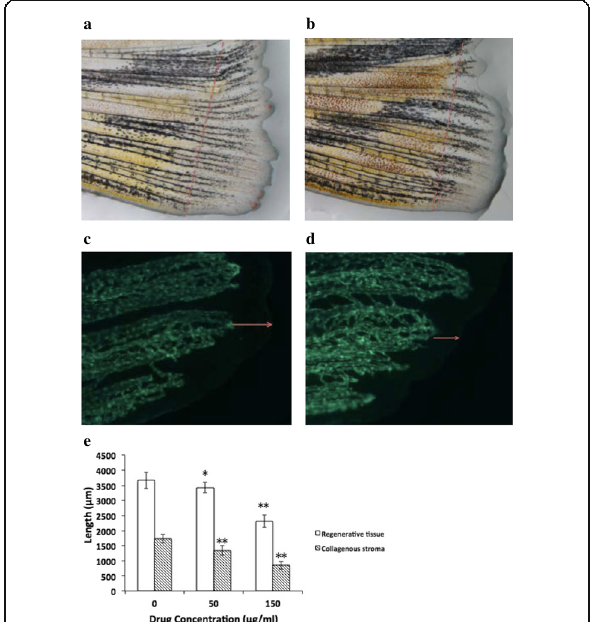
Fig. 8 Antiangiogenic effect of oridonin in adult zebrafish. The average lengths of the regenerated tissues were measured and calculated. a control group (regular light); b 150 μ g/ml oridonin group (regular light); c control group (fluorescent light); d 150 μ g/ml oridonin group (fluorescent light); e Length comparison. The asterisks indicate statistically significant differences from the control group (* P < 0.05, ** P < 0.01)